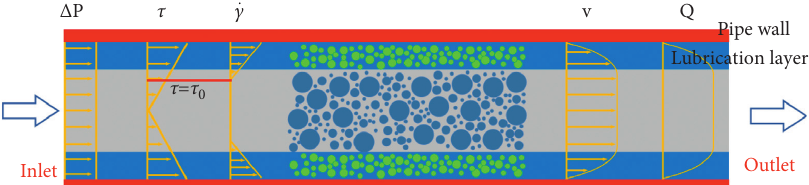
Figure 2: Pressure, shear stress, shear rate, velocity, and discharge rate profiles inside a pumping